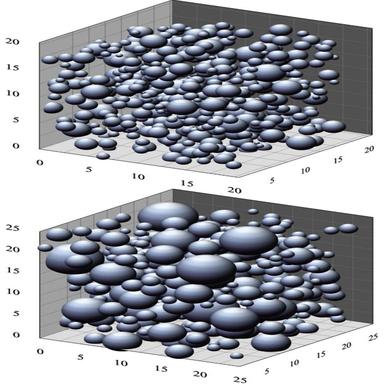
Initial (upper panel) and final (lower panel) configurations, the final volume being the double initial volume. Initial population includes 532 pores with total porosity of 9%, the final porosity equals to 26%.